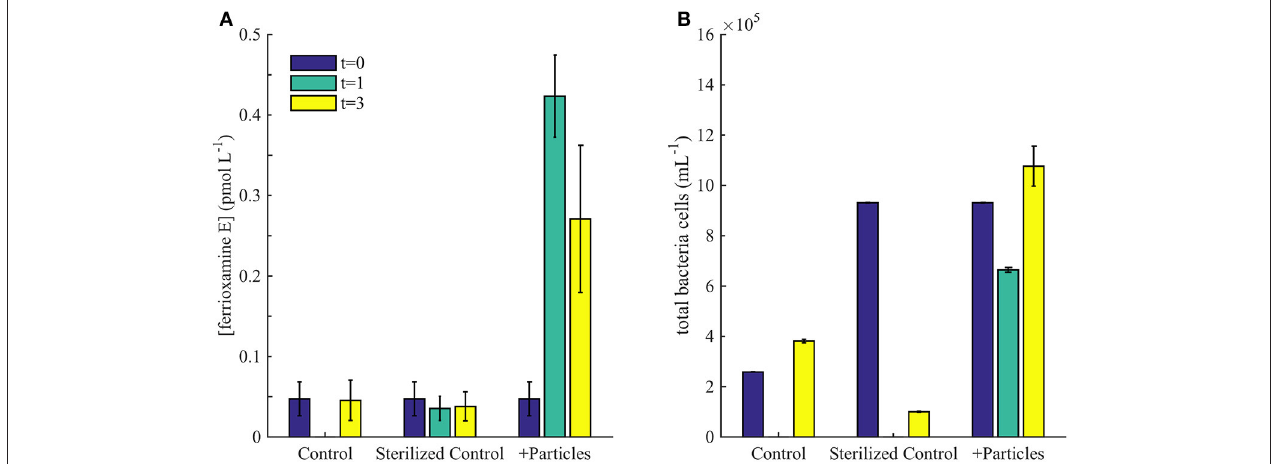
FIGURE 5 | (A) Concentrations of ferrioxamine E observed in particle incubation experiment on day 0, 1, and 3. (B) Flow cytometry cell counts during the incubation